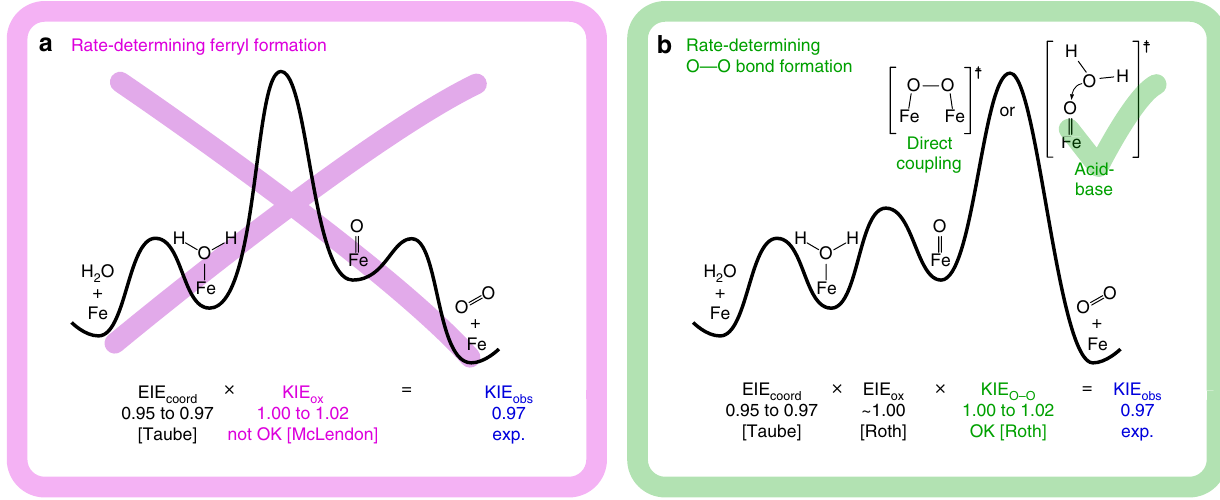
Fig. 5 Qualitative energy diagrams for the mechanistic interpretation of the observed 18 O KIE. The mechanistic interpretation is provided in the framework of the minimal reaction mechanism sketched in Fig. 1. It shows two distinct reaction steps as potentially rate-determining: 1,11,13,17,21,63 either a the local oxidation and deprotonation to a reactive metal-oxo or b the O − O bond formation with two distinct possible mechanisms. For the fi rst scenario, the 18 O KIE determined experimentally (KIE obs ) is not consistent with the range of values expected from literature data, whereas for the latter case KIE obs is in agreement with the data available so far, indicating an acid-base mechanism rather than direct oxo coupling 25,27,44,66 . The overall 18 O KIE determined (KIE obs ) represents the product of the equilibrium isotope effect (EIE) for H 2 O-binding (EIE coord ) and the intrinsic KIE for the oxidation/deprotonation